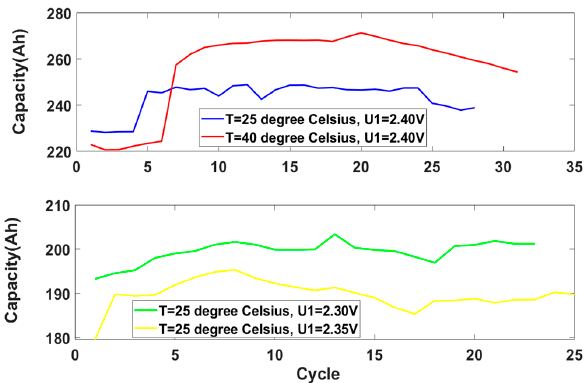
Figure 2. The capacity degradation trajectory under different working conditions.